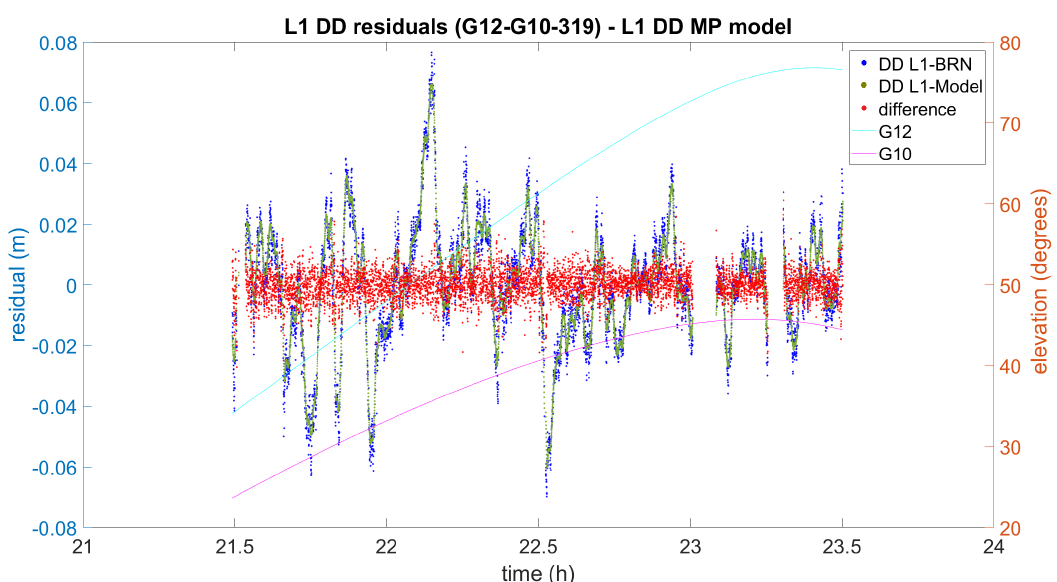
Figure 8. The result of L1 DD multipath mitigation for satellites G12 and G10 (2016 DOY319). DD L1-BRN and DD L1-Model denote the DD L1 residuals obtained by means of Bernese and the use of the Model, respectively.